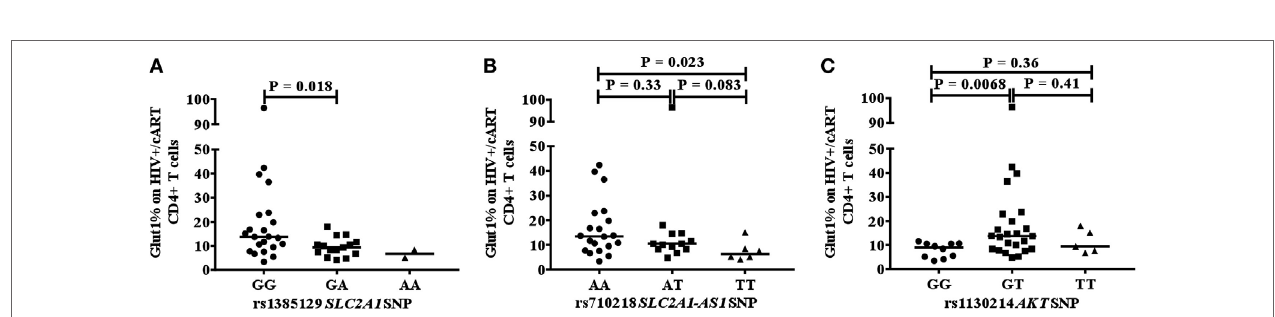
FigUre 3 | Association between CD4 + Glut1 + T cell percentage and genetic polymorphisms associated with the SLC2A1 SNPs rs1385129 (a) SLC2A1-AS1 SNP rs710218 (B) , AKT SNP rs1130214 (c) . cART, combination antiretroviral therapy; SNP, single nucleotide polymorphisms.